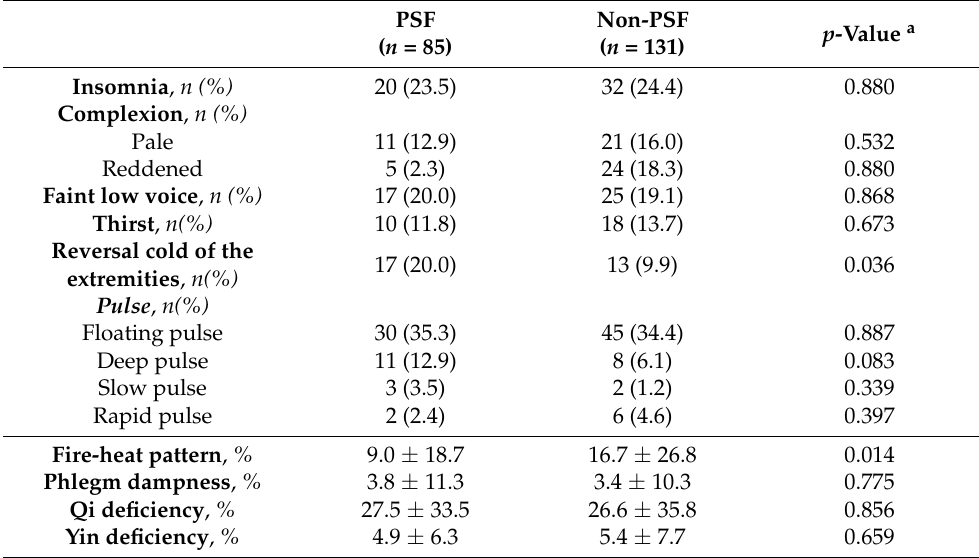
Table 6. Comparison of clinical features and pattern identification between the PSF and non-PSF groups.